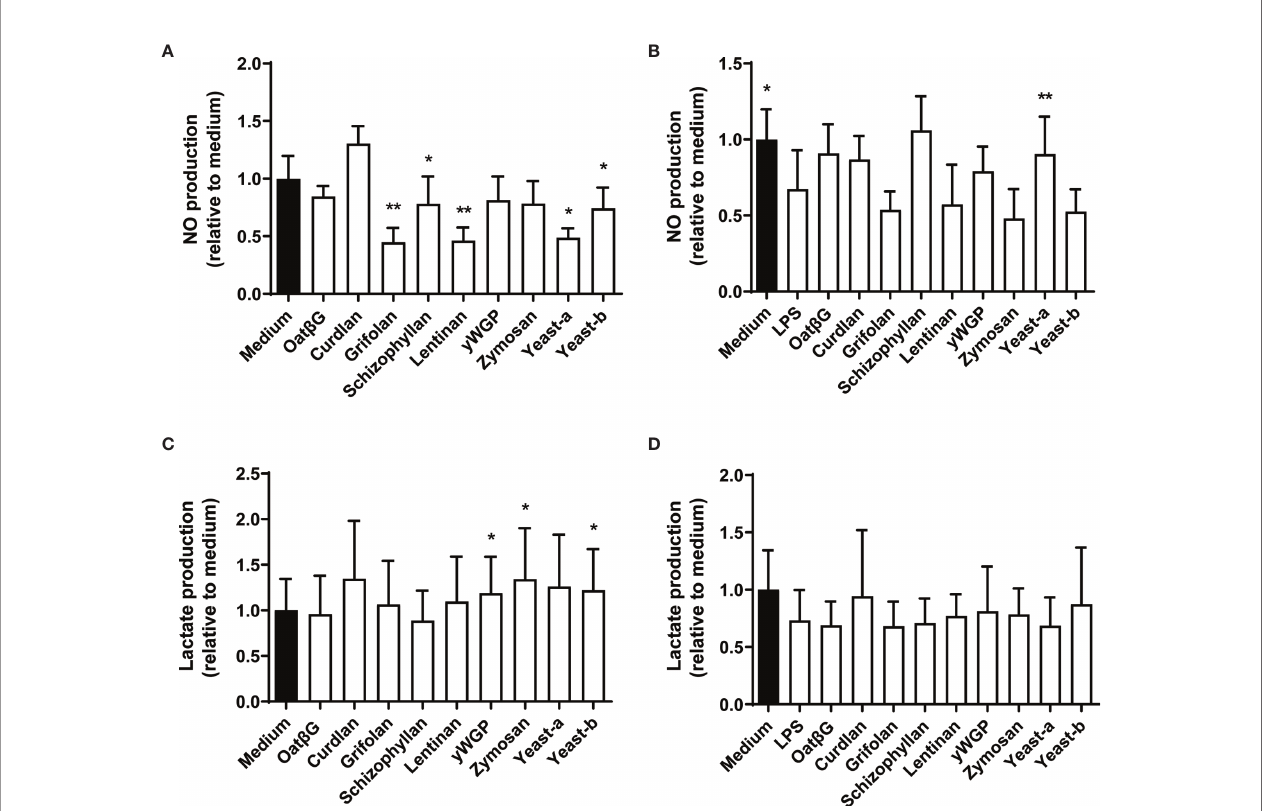
FIGURE 6 | The induction of training and resilience in macrophages by various b -glucans affects NO and lactate secretion. Human monocytes were trained (A, C) and resilience was induced (B, D) as described in the legend to Figure 3 . Nitric oxide (A, B) was determined before challenging the macrophages with LPS at day 7 and lactate (C, D) release was determined after day 7 of LPS challenge. NO and lactate levels were determined in the supernatant and shown as percentages relative to non-treated macrophages (medium is set at 100%). Results are shown in bar graphs as average ± SD of n =3-5 different donors. Data was analyzed with paired Student ’ s t test and statistical signi fi cances were indicated: *P < 0.05 compared to the no b -glucan (medium) control; **P < 0.01 compared to the medium